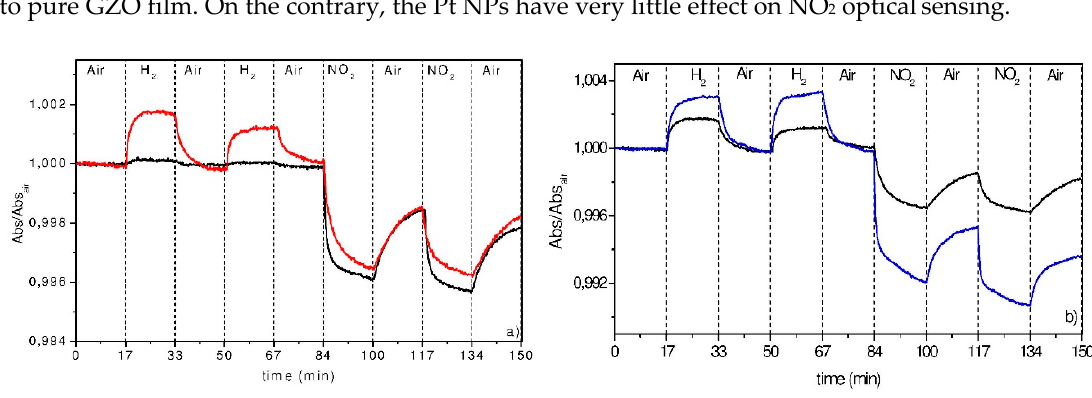
Figure 1. ( a ) Dynamic absorption change for two cycles Air/H 2 1% and two cycles Air/NO 2 1000 ppm at 2400 nm and at 150 °C OT for GZO film with 5% Ga uncoated (black line) and coated (red line) with Pt NPs. ( b ) Dynamic absorption change for two cycles Air/H 2 1% and two cycles Air/NO 2 1000ppm at 2400 nm and at 80 °C OT for GZO film with 5% (black line) and 10% (blue line)